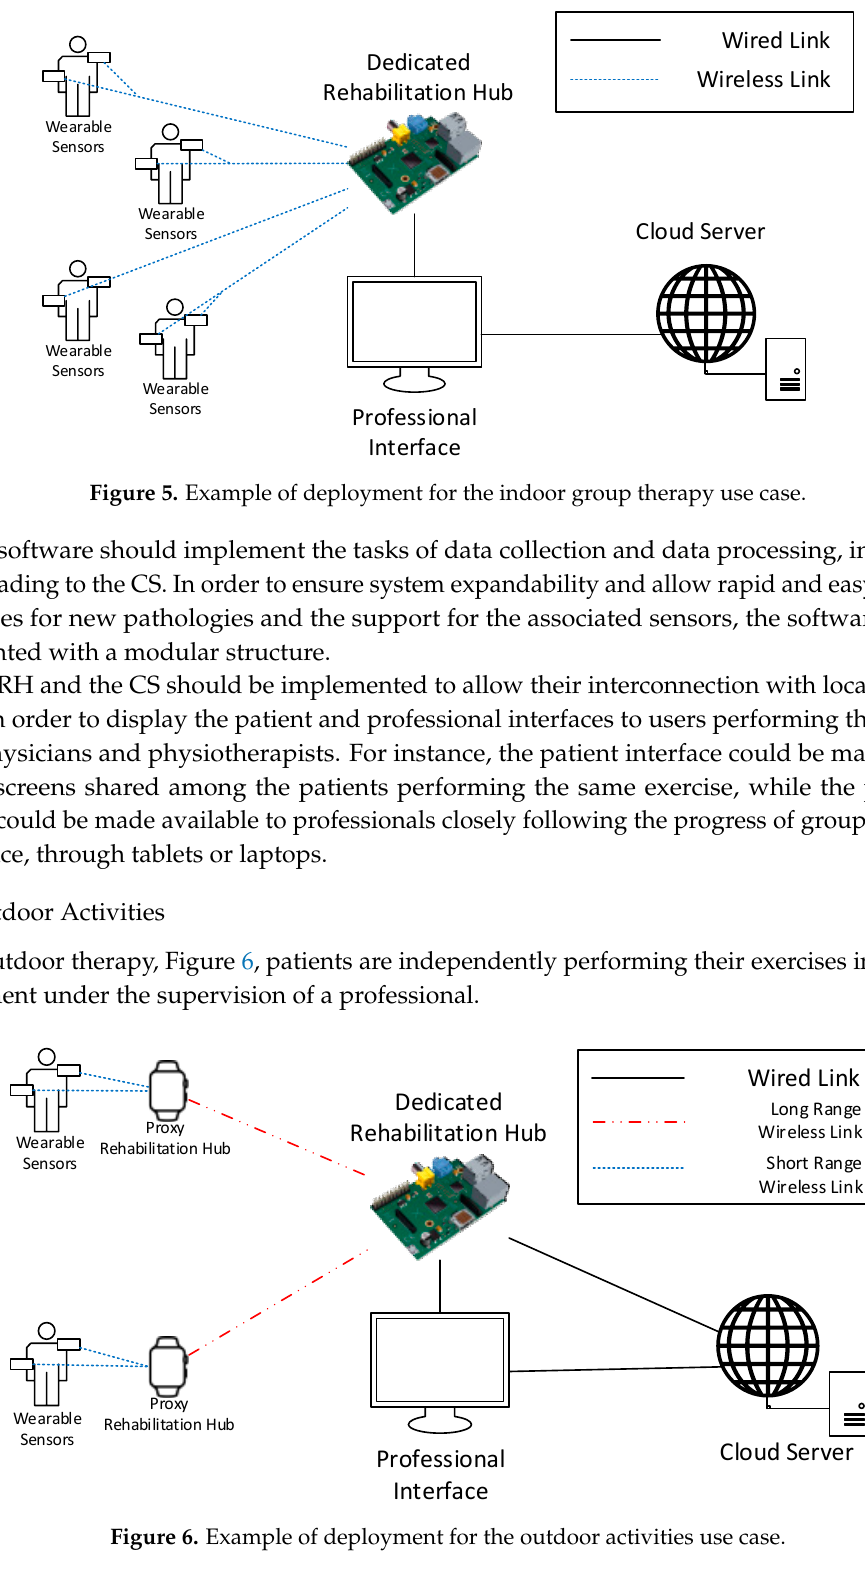
Figure 6. Example of deployment for the outdoor activities use case.